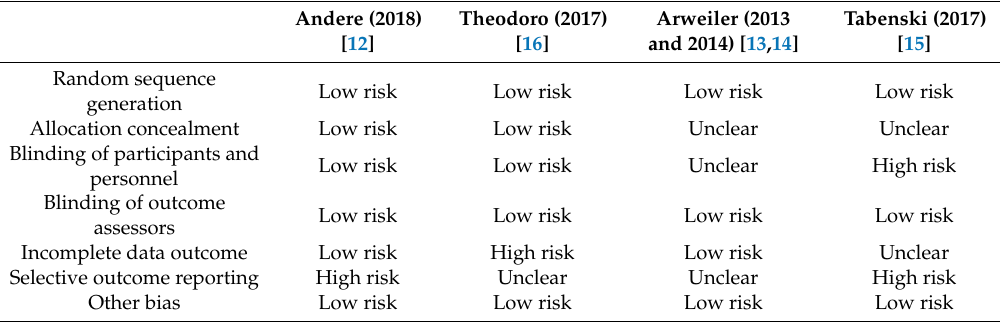
Table 3. Risk of bias for the four